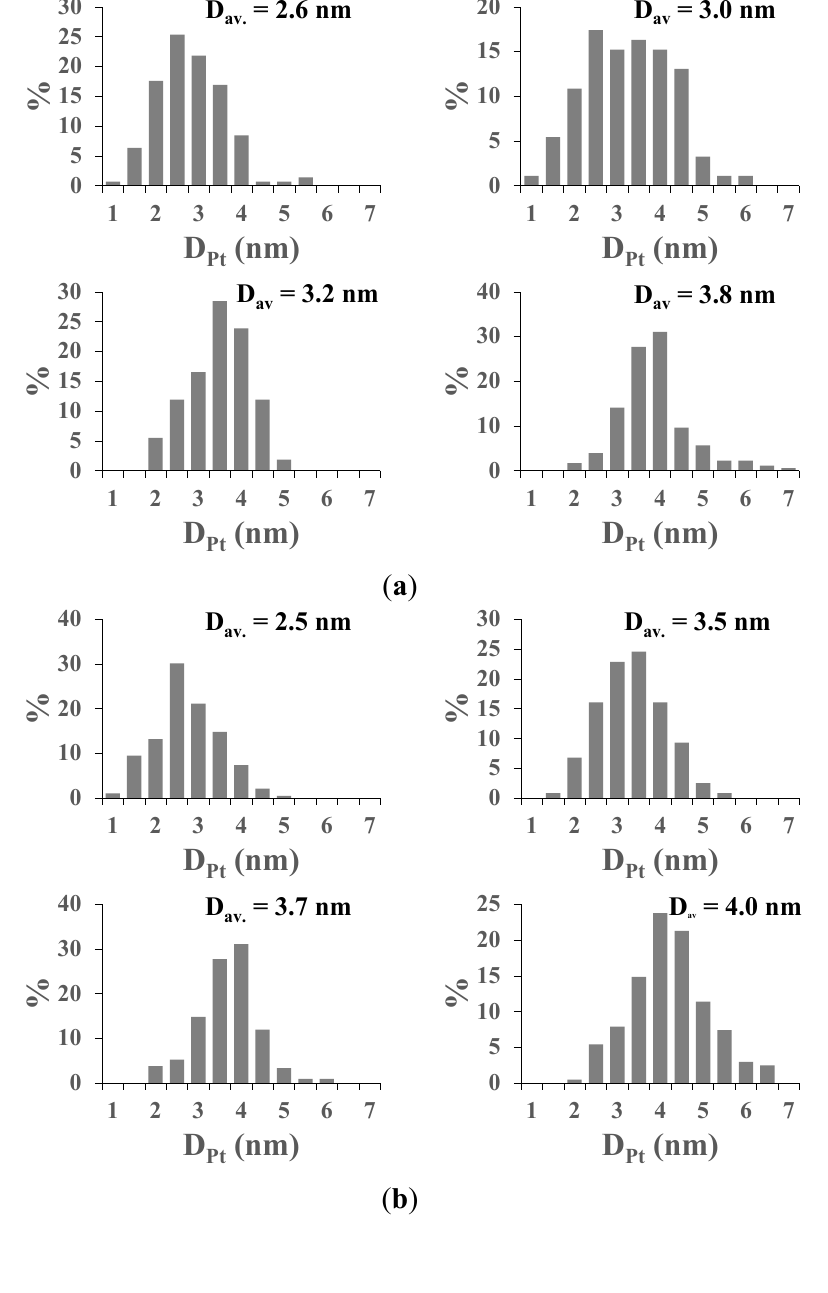
Figure 2. Relative frequency of the formed Pt nanoparticles according to the particle